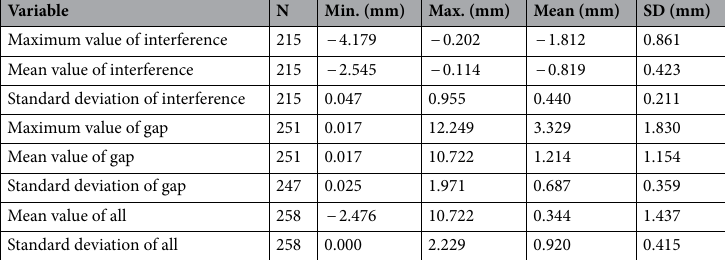
Table 3. The descriptive statistics of the result of deviation analysis